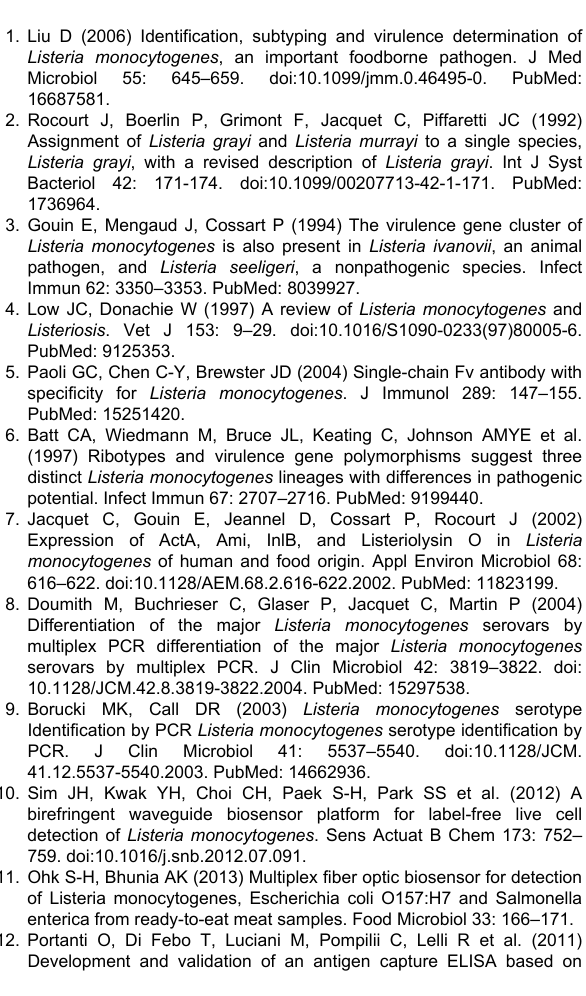
Figure S1. Multiple sequence alignment for DNA sequences from alternative round 4B generated using ClustalW2 2.1 (http://www.ebi.ac.uk/Tools/msa/clustalw2/).